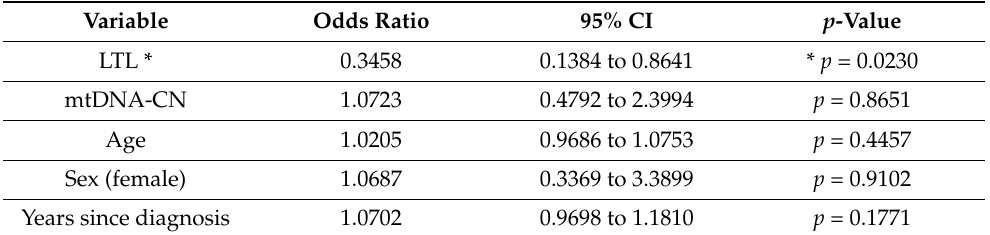
Table 2. The binary logistic regression model evaluated characteristics to predict severe disability in patients with RRMS.